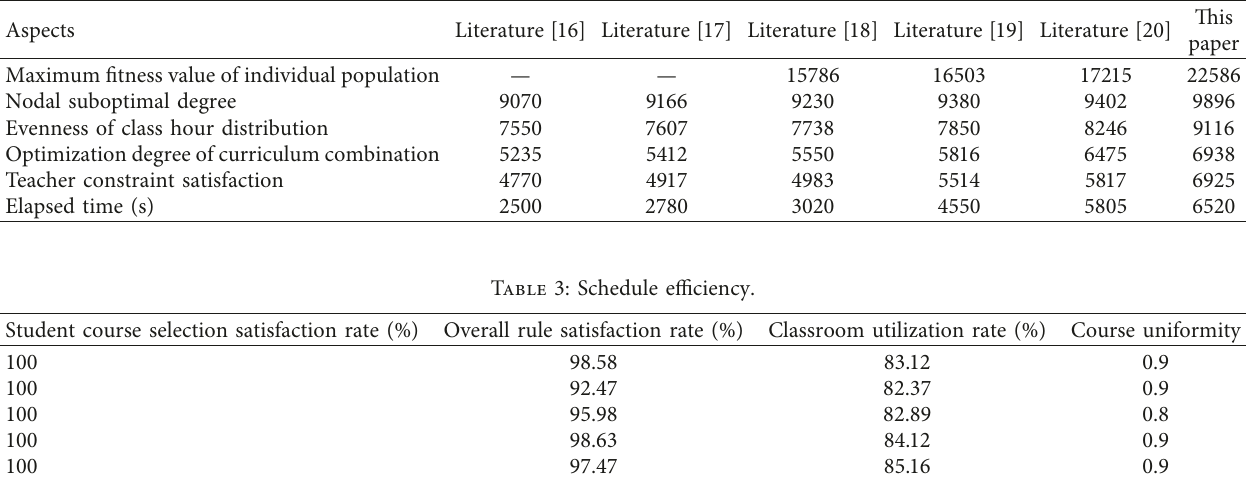
Table 2: Comparative experimental results of performance evaluation of several different